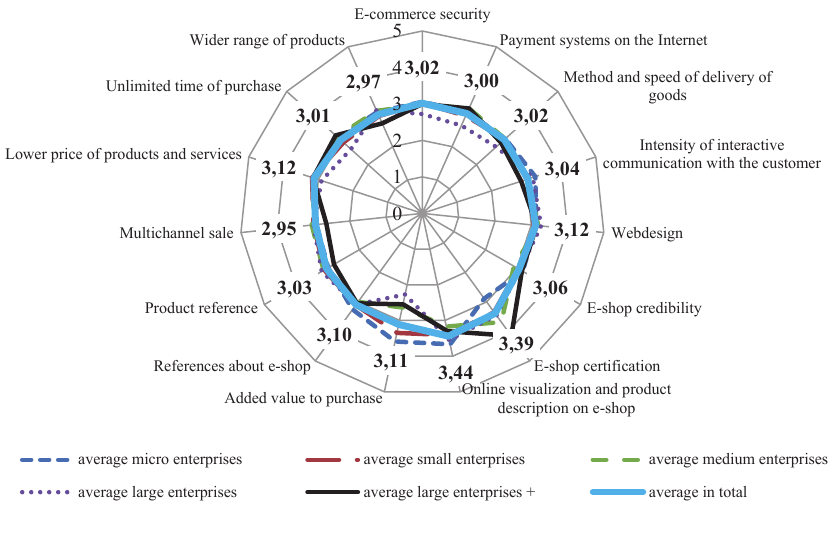
Fig. 2 – Average evaluation of the importance of determinants of online shopping behavior for strategic management in e-commerce. Source: own